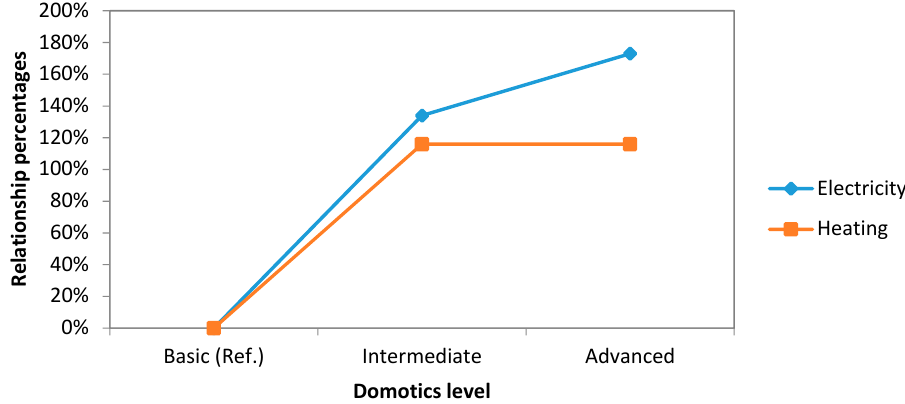
Figure 8. Comparative study graph concerning to energy savings (electricity and heating).